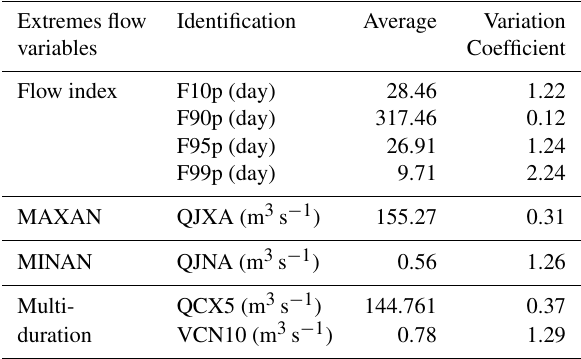
Table 3. Extreme flow characteristic variables average (1962–